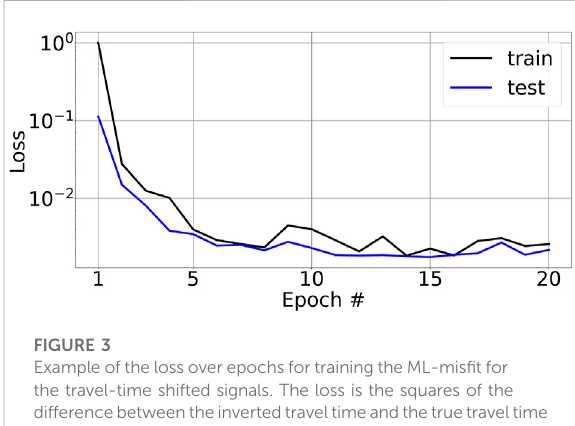
FIGURE 3 Example of the loss over epochs for training the ML-mis fi t for the travel-time shifted signals. The loss is the squares of the differencebetweentheinvertedtraveltimeandthetruetraveltime de fi ned in Eq.